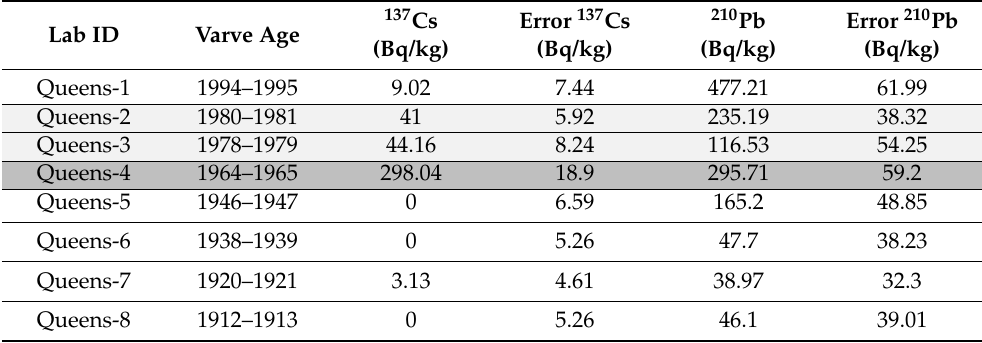
Table 1. Summary of gamma analysis of bulk sediment sampled along varve boundaries in freeze core CRA22-1FR-3. Grey shading identifies peak in 137 Cs activity, consistent with global peak in 1964 CE. B, Cumming, Queen’s U., analyst, using methodology described in McCarthy et al. Adapted with permission from [30] McCarthy et al. in